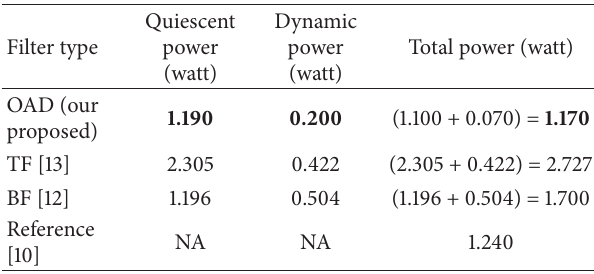
Table 3: Power utilization for Virtex-5 OpenSPARC architecture measured for an image of resolution 150 ×